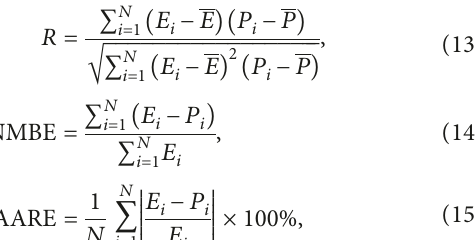
Figure 16: Parabolic fitting for low values, and a positive NMBE value means overprediction, while negative one means underprediction from a model. AARE is an unbiased statistic that estimates the accuracy of predictions by comparing the relative error term by term.